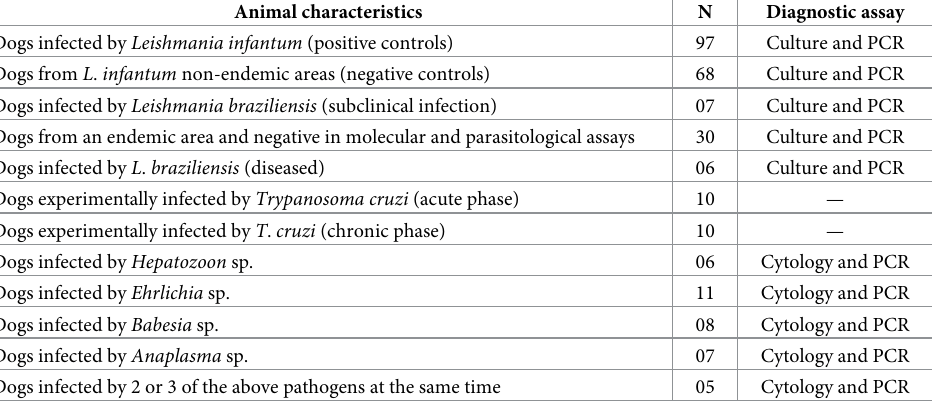
Table 1. Characterization of the dogs from which the serum samples used in this experiment were obtained. The L . infantum negative and positive controls were used for the ELISA standardization and establishment of the validation parameters. The serum samples taken from dogs infected with other pathogens than L . infantum were used for the cross-reactivity assay.